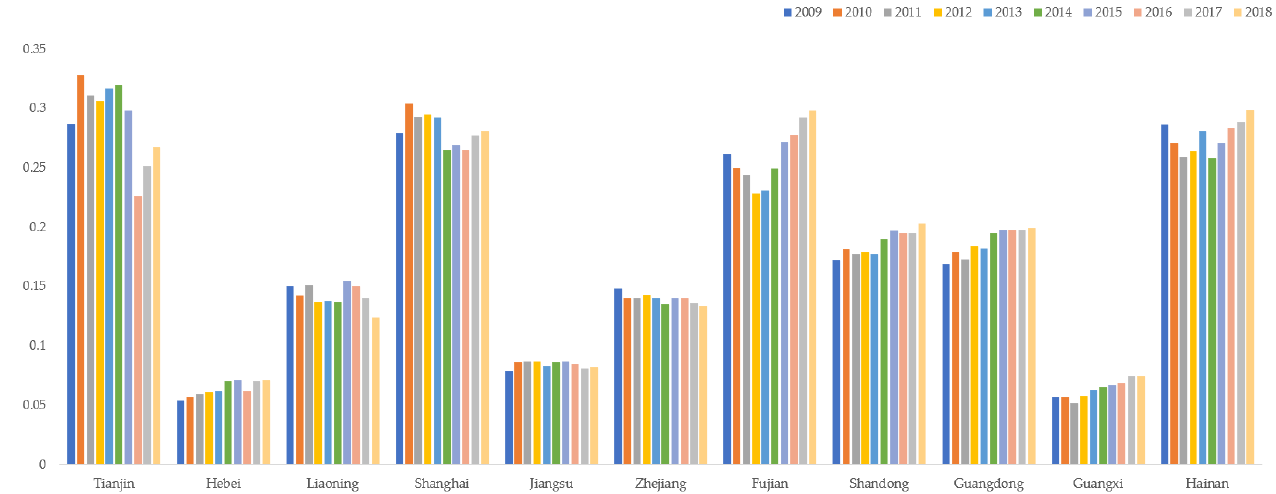
Figure 2. Proportion of marine GDP to regional GDP in coastal provinces and cities.